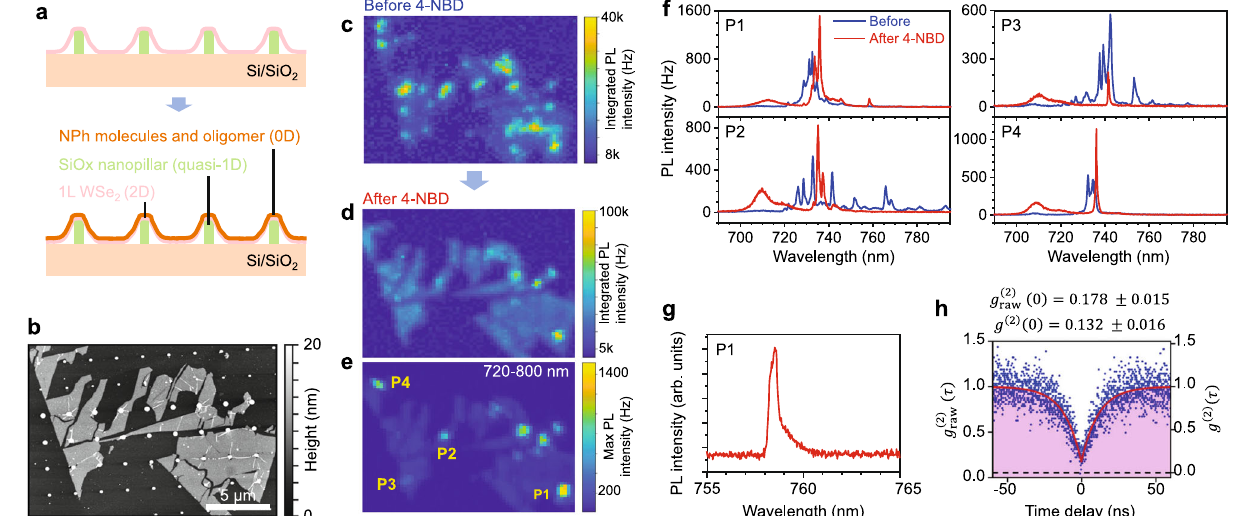
Fig. 3 | Chemomechanically modi fi ed emitters on a nanopillar array. a Schematic of the mixed-dimensionalheterostructures consisting of consisting of nitrophenyl (NPh) oligomers (0D), nanopillars (quasi-1D), and 1L WSe 2 (2D) that alsohostthequantumemitter(0D). b Atomicforcemicroscopy(AFM)imageofa1L WSe 2 fl akeonananopillararrayafter4-nitrobenzenediazonium(4-NBD)treatment. c Low-temperature ( T =1.7K) photoluminescence (PL) map of integrated intensity oftheas-transferred fl akebeforethe4-NBDtreatment. d , e PLmapsafterthe4-NBD treatment, showing ( d ) integrated intensity over the measured spectral range and